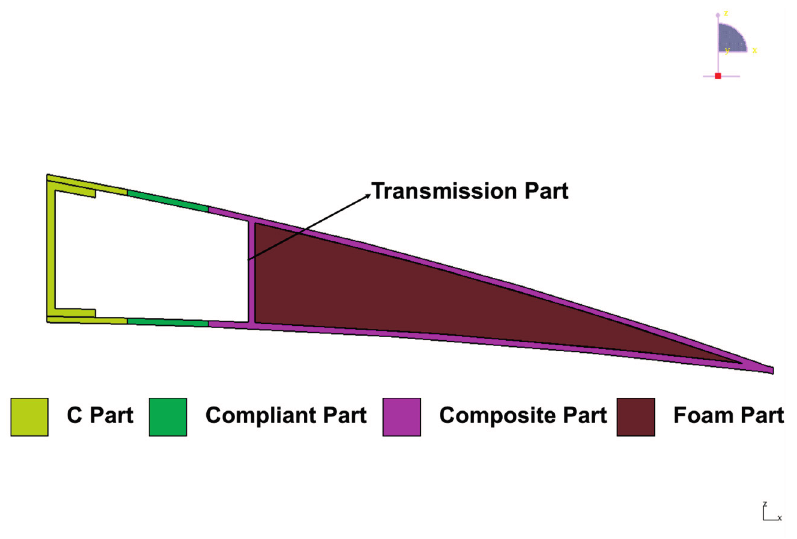
Figure 3. Hybrid trailing edge closed cell control surface